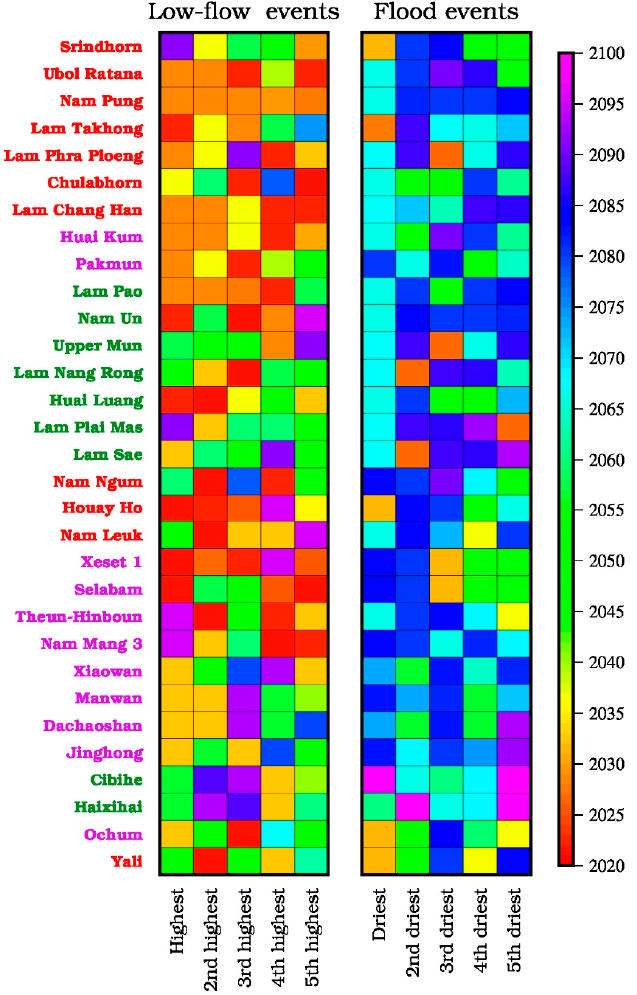
Figure 4. The projected year of occurrence of the extreme five flood events and driest low flow events for the MRB dams between 2021 and 2099 using four climate models under RCP 4.5 and RCP